Question: Based on the figure, does the quantity rise or fall?
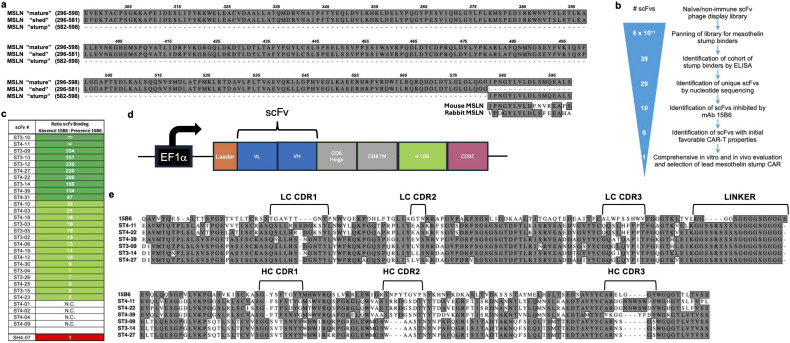
Answer: increasing